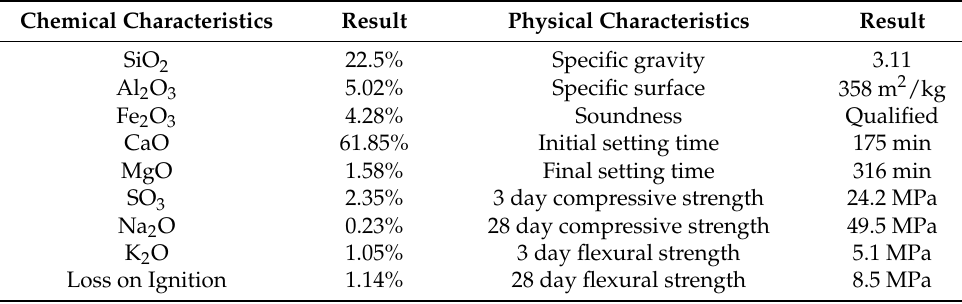
Table 1. General properties of ordinary Portland